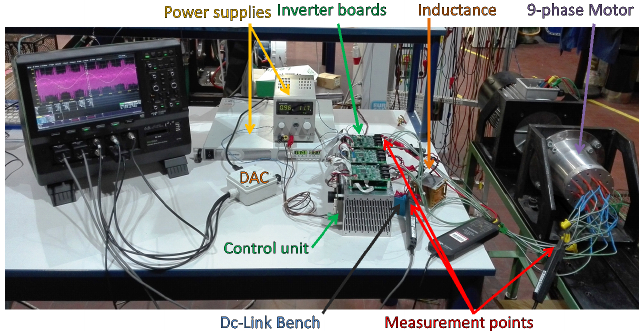
Figure 20. Experimental setup: triple 3-phase motors, the control board and the power section with one triple-3-phase converter.